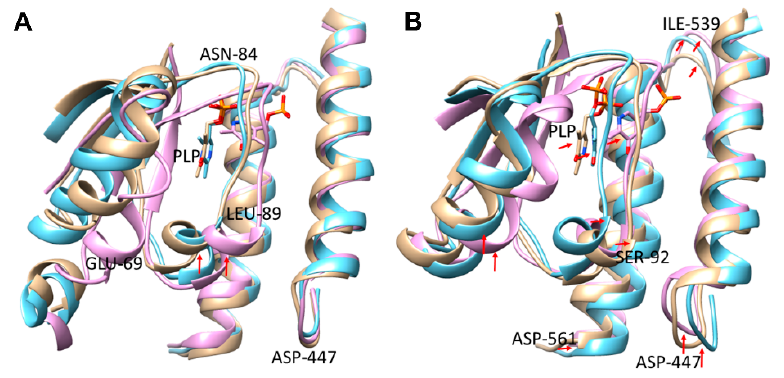
Figure 5. Aligned binding site interacting domains. ( A ) Structure indicating conformational changes of protein residues for the WT and mutants at 40 °C. ( B ). Binding pocket PLP and residue alterations at 60 °C.